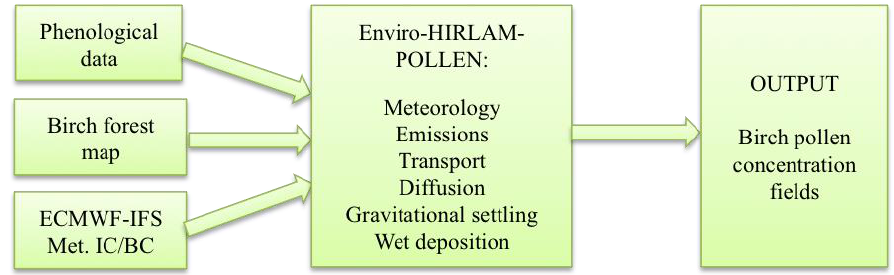
Figure 11. General scheme of Enviro-HIRLAM birch pollen